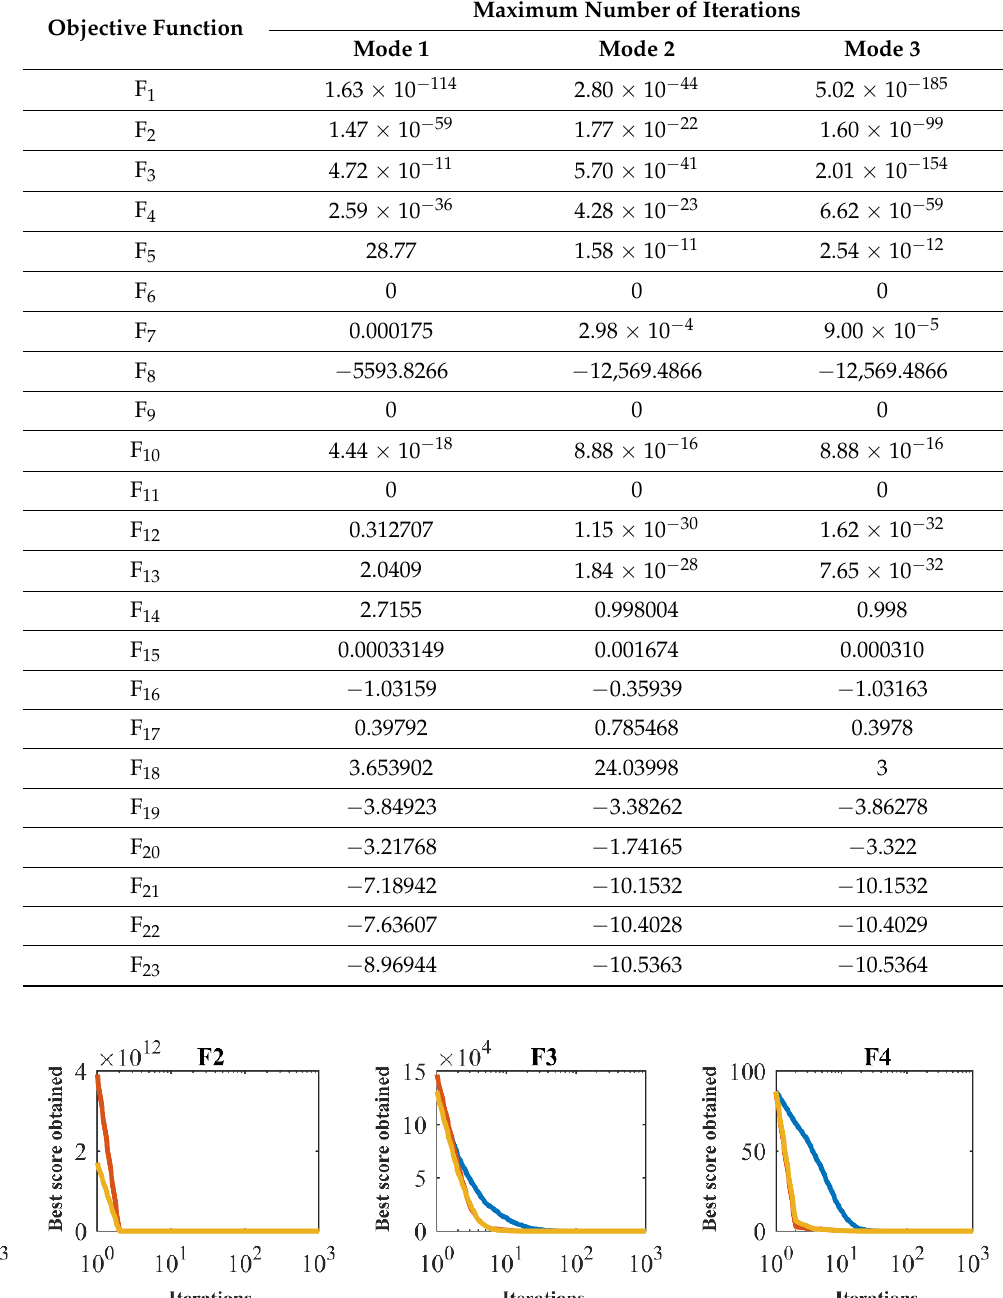
Table 8. Results of sensitivity analysis of SSVUBA to the effectiveness of each case in Equation (4).